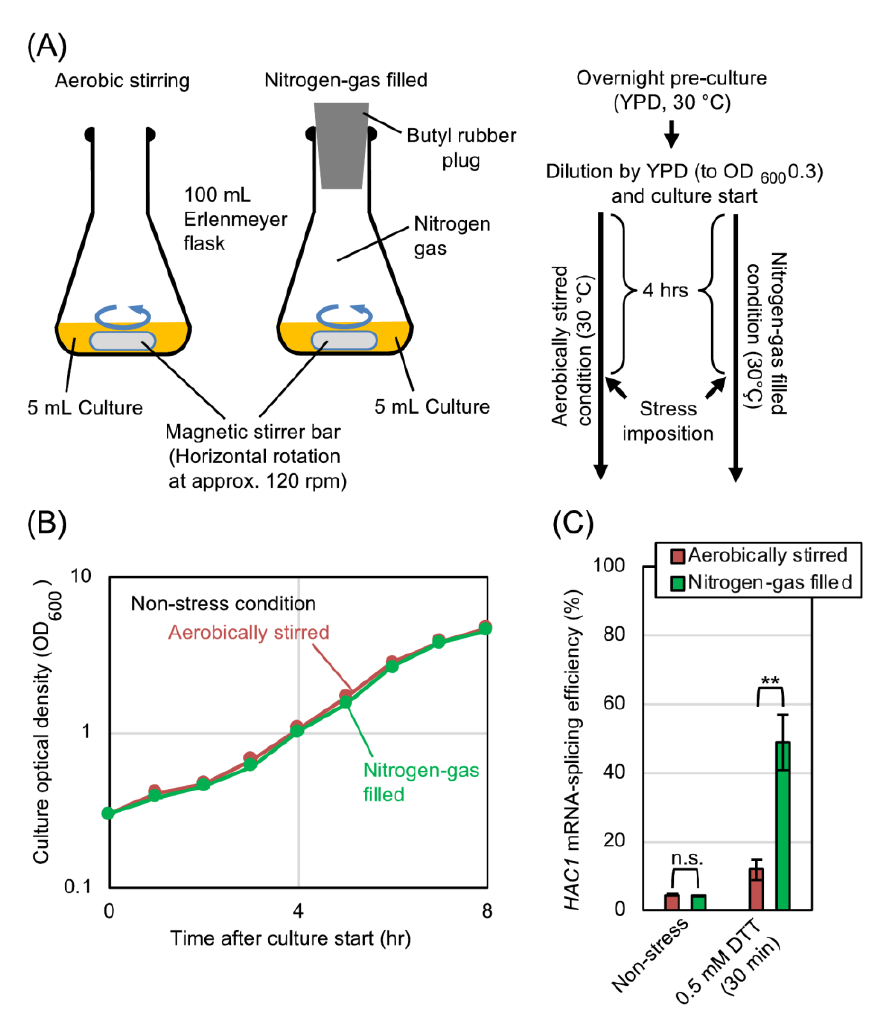
FIGURE: 2 Hypoxic treatment boosts HAC1 -mRNA splicing even in agitat- ed cultures. (A) Procedures for cul- turing and ER-stress induction of S. cerevisiae cells under the aerobi- cally stirred condition or under the nitrogen-gas filled condition. DTT was added to the media 4 hr after culture start. (B) Optical density of cultures (BY4742 cells) was moni- tored under non-stress conditions. (C) BY4742 cells were cultured and were ER-stressed (or remained non- stressed) as shown in panel A, and were checked for HAC1 -mRNA splic- ing. n.s. (not significant): p > 0.05, **: p <